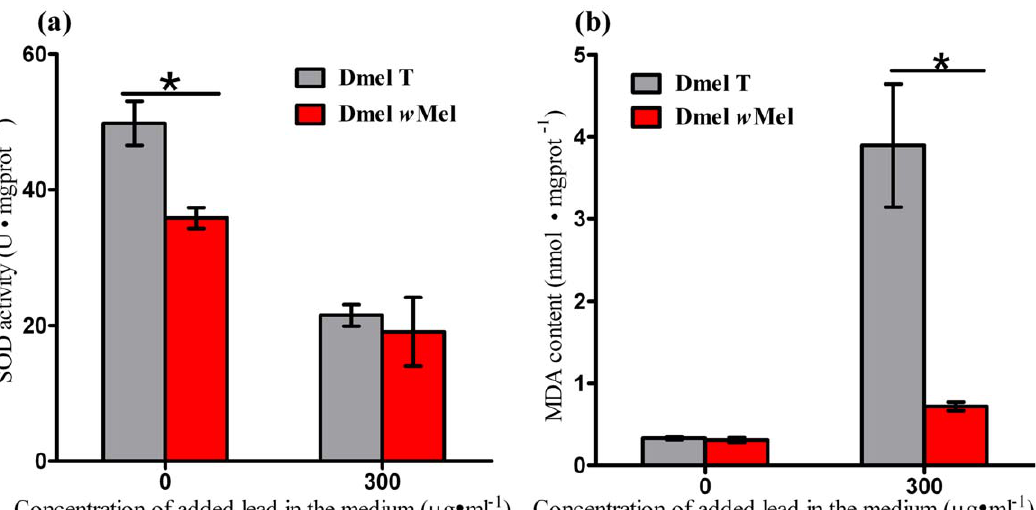
Figure 4. Wolbachia infection limited peroxidation in Drosophila larvae cultured in the medium infused 300 m g ? ml 2 1 of lead. ( a ) Comparison of SOD activities in Dmel w Mel and Dmel T larvae after challenge with lead. ( b ) Comparison of MDA contents in Dmel w Mel and Dmel T larvae after challenge with lead. Bars=standard error; ‘‘*’’ indicated P , 0.05.